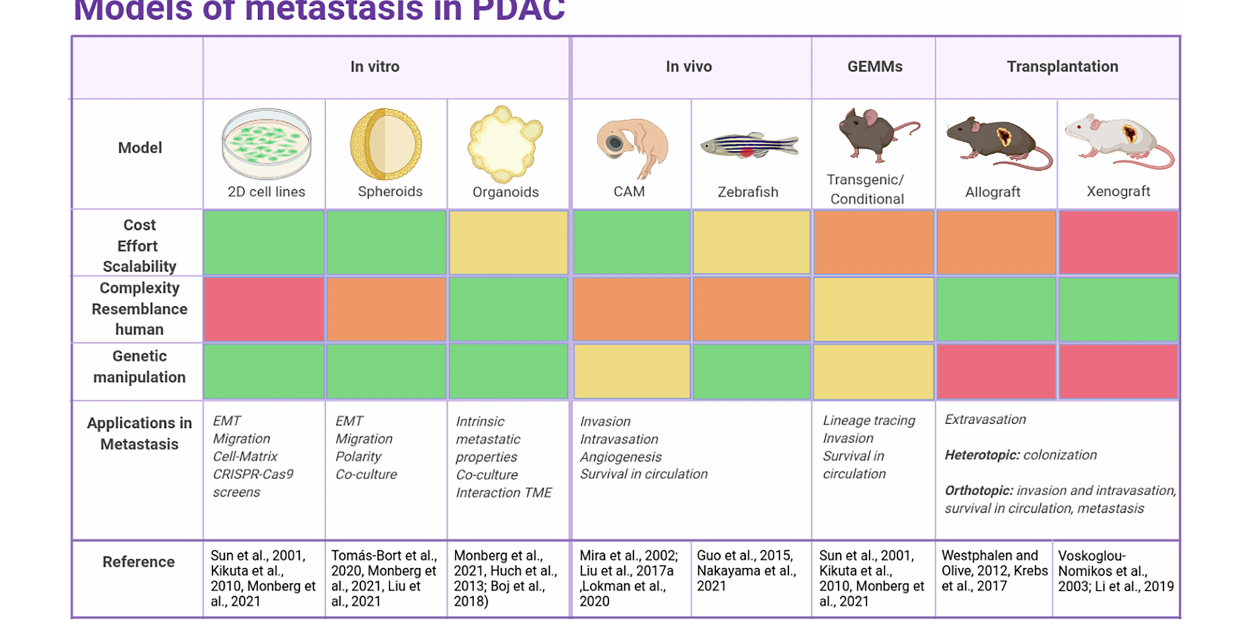
FIGURE 2 | Overview of the current models to study metastasis in PDAC. The color scale indicates whether a model is more suitable (green) or less (red) for each